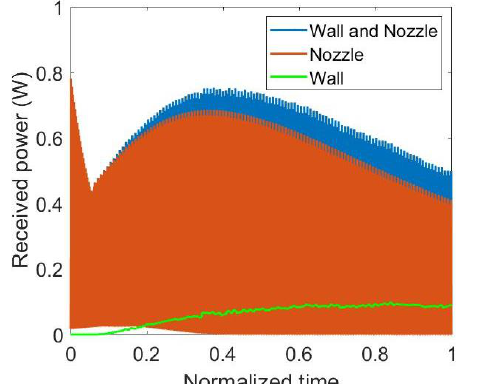
Figure 9. Detailed results for radiative heat power